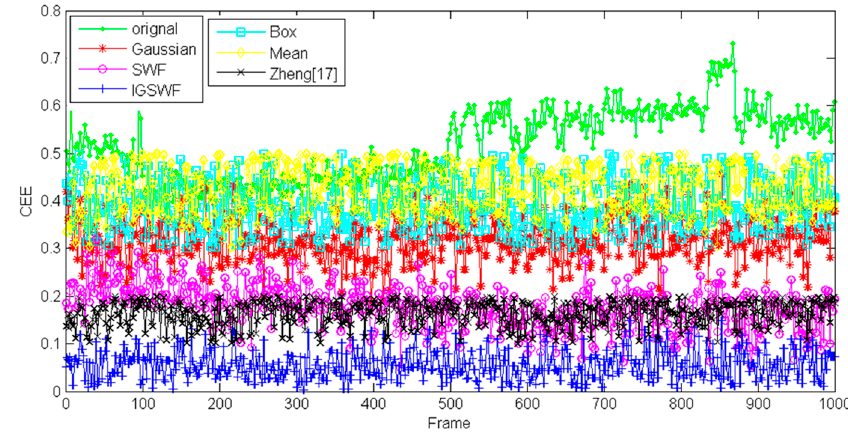
Figure 19. Comparison of the CEE curves of the different algorithms.